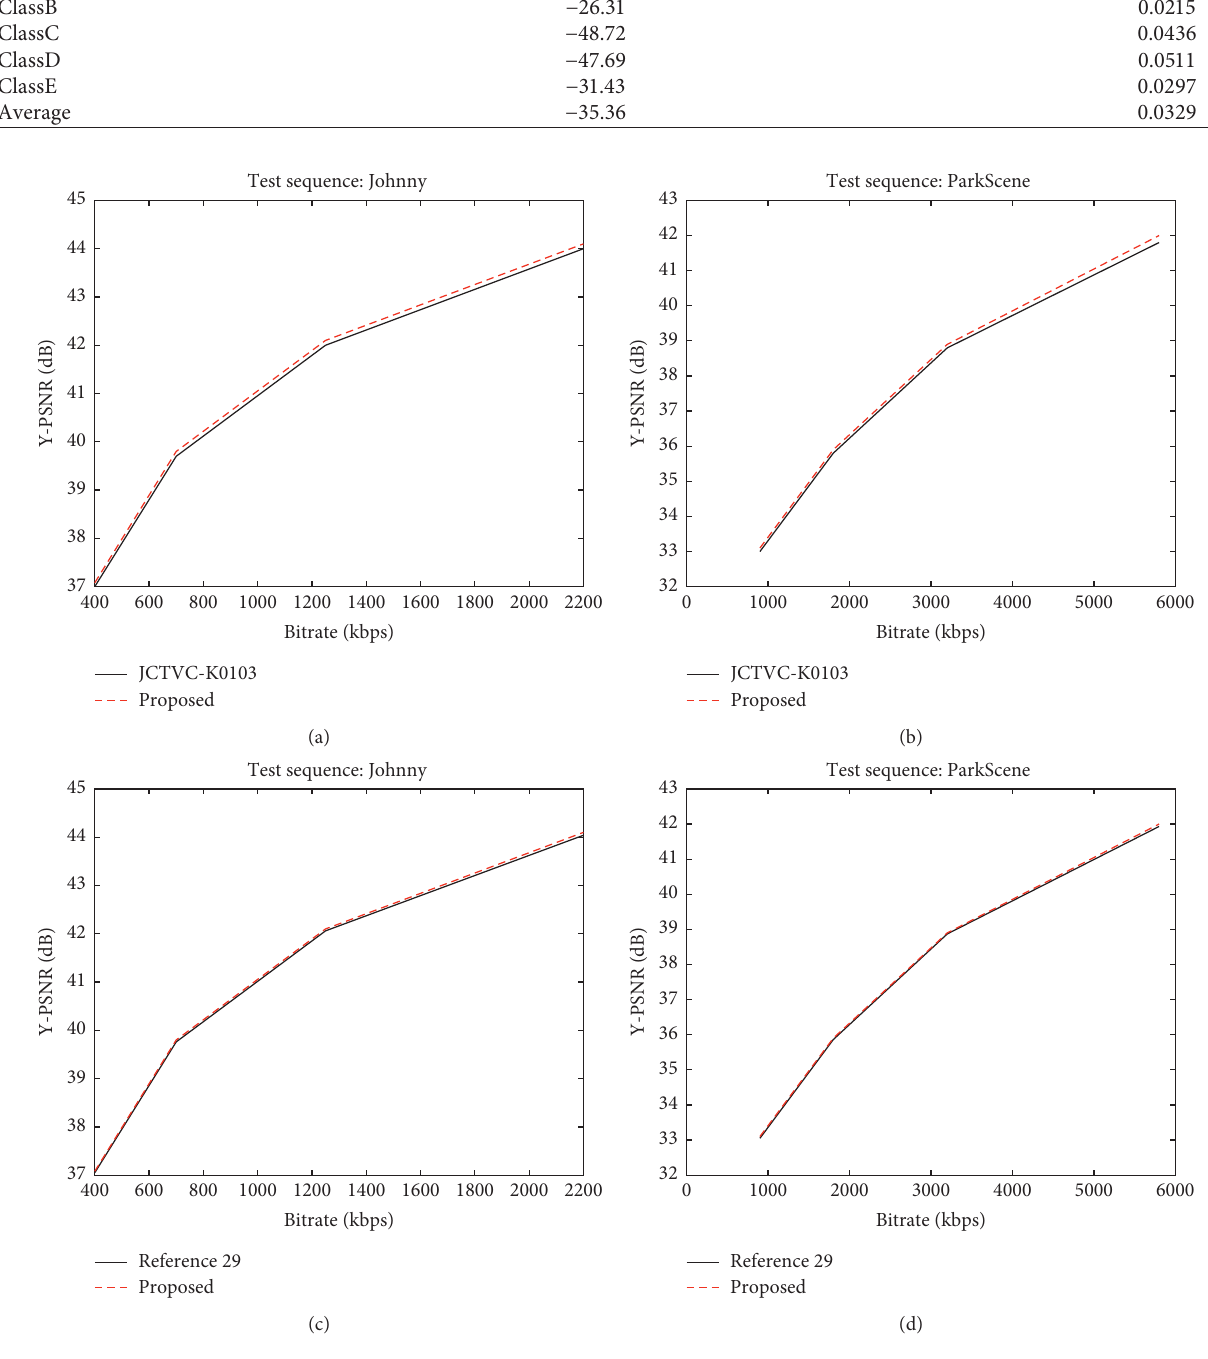
Figure 9: Comparison of rate distortion performance among three algorithms. The rate-distortion curve of (a, c) Johnny sequences and (b, d) ParkScene